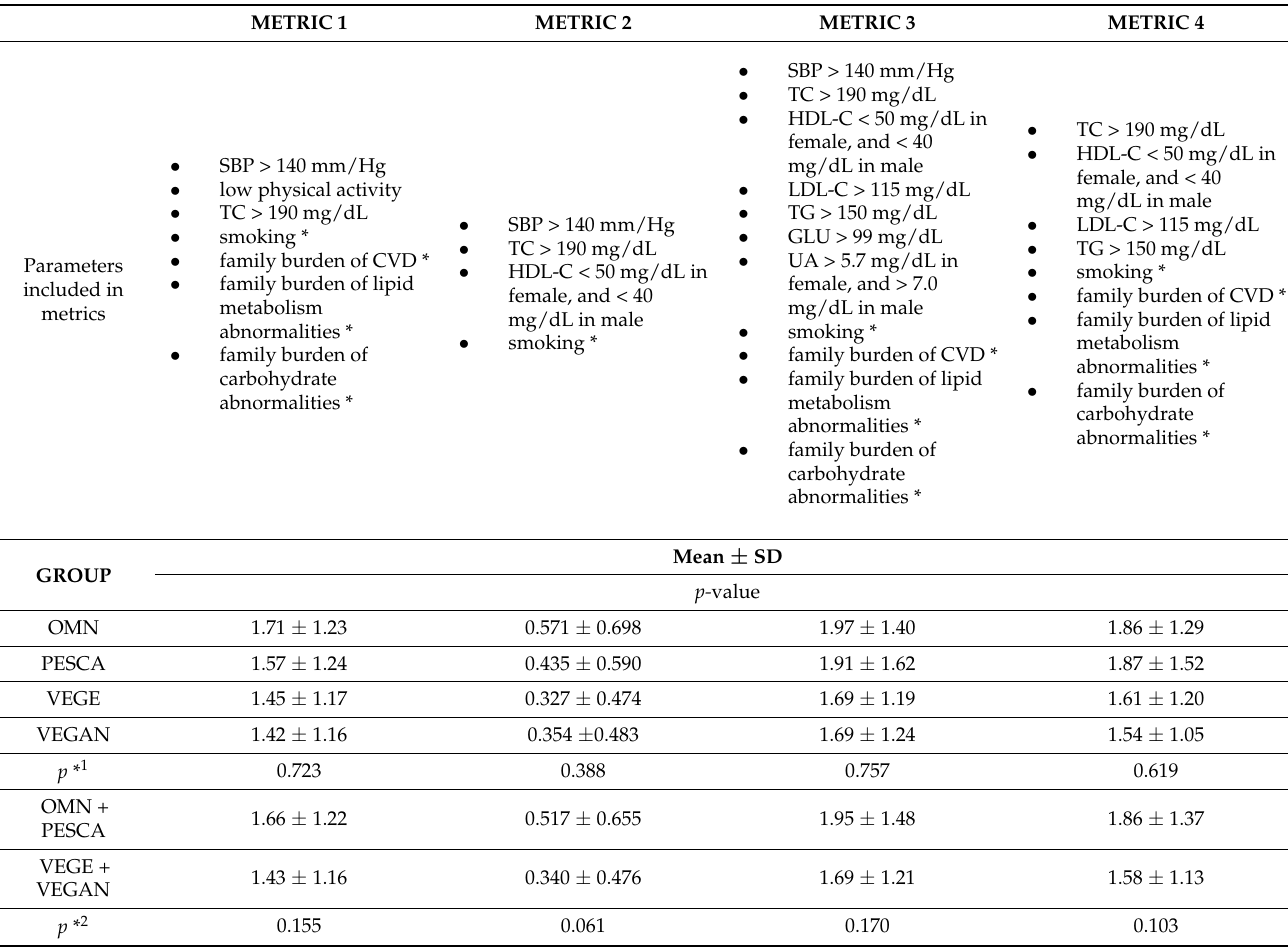
Table 3. Trial for estimating CV by use of